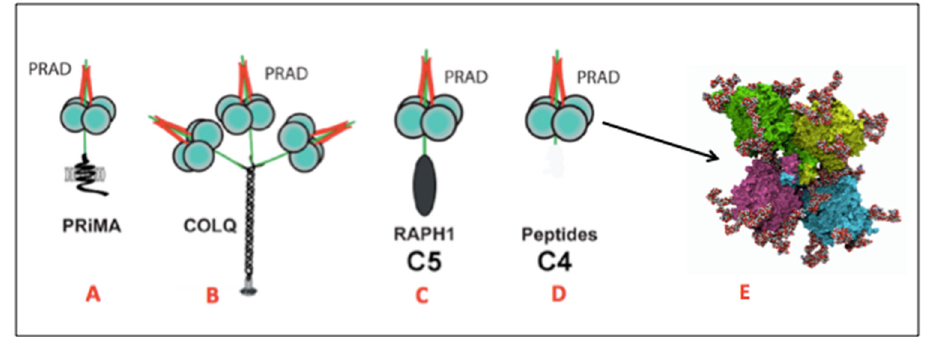
Figure 1. Quaternary and quinary structure of cholinesterases. Both ChEs display the same monomeric fold ( α / β ) and similar upper 3D structure levels. ( A ) Membrane-anchored acetylcholinesterases (AChE) anchored by PRiMA (proline-rich membrane anchor) in central nervous system cholinergic synapses. ( B ) Matrix-anchored cholinesterases anchored by ColQ (collagenous subunit) at neuromuscular junctions. ( C ) Soluble human plasma butyrylcholinesterase C 5 isoenzyme: tetrameric form linked to Raph 1 subunit [9]. ( D ) Soluble human plasma butyrylcholinesterase (BChE) tetrameric form: dimer of disulfide-bonded dimers linked through PRAD (proline-rich attachment domain) peptide. ( E ) Three-dimensional structure of human BChE tetramer as determined by cryo-electron microscopy [10,11]. Nine asparagine-linked glycan chains of complex type per subunit correspond to 24% of the total protein mass (340 kDa).